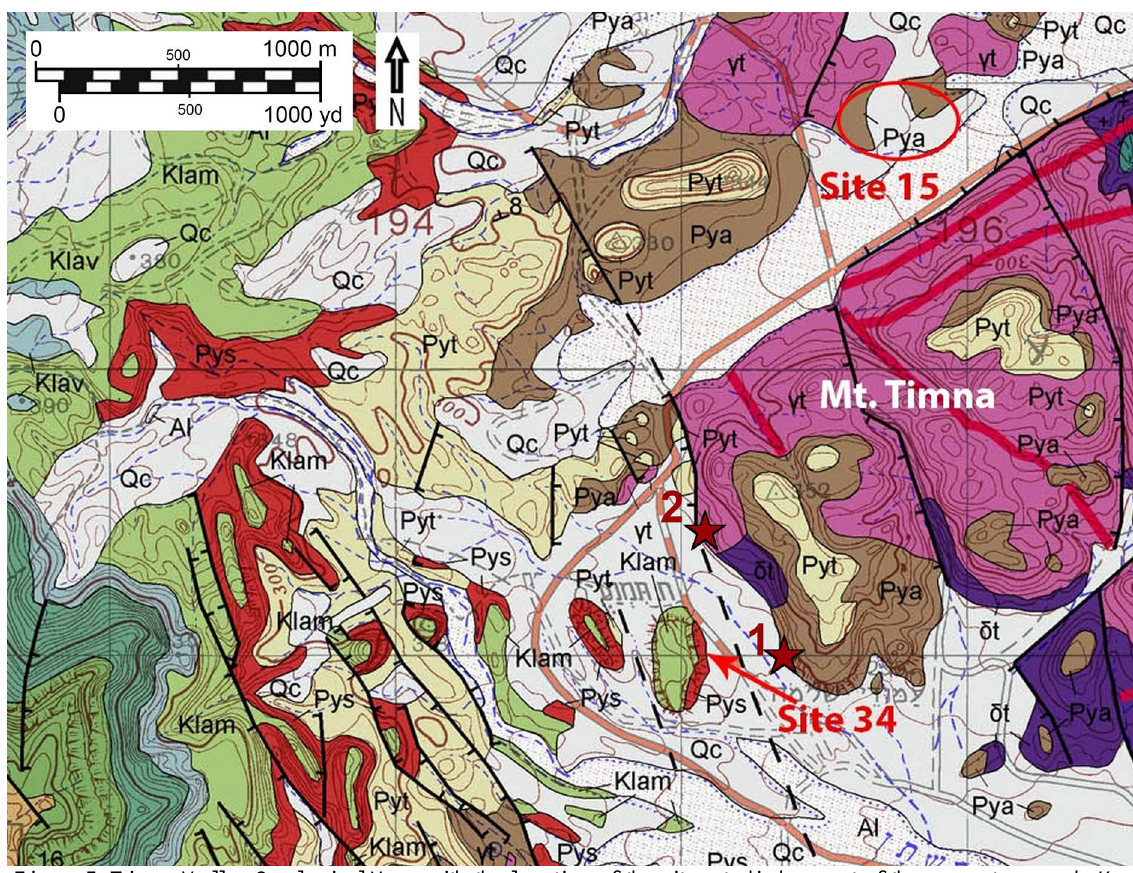
Figure 5. Timna Valley Geological Map with the location of the sites studied as part of the current research. Key for major rock types in the map: Klam (light green) = Amir Formation sandstones; Pys (red) = Shehoret Formation sandstones; Pya (brown) = Amudei Shlomo Formation; Pyt (yellow) = Timna Formation (dolomite); ϒt (light purple) = Alkali Granite; δt (dark purple) = Monzodiorite; QC = Stream terraces. (Adapted from the Be’er Ora Geological Map; Beyth et al .